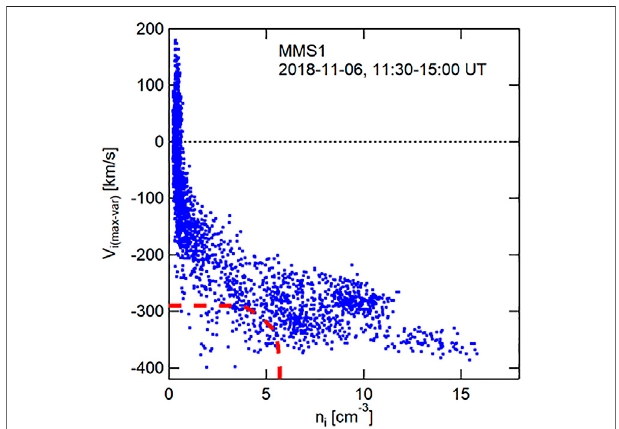
FIGURE 5 | MMS ion bulk velocity along maximum variance direction during this interval, as a function of the ion number density. Positive velocities are in the sunward direction. Low density, larger anti-sunward speeds (below the red dashed curve) are indicative of Kelvin-Helmholtz activity, with plasma mixing within well-developed